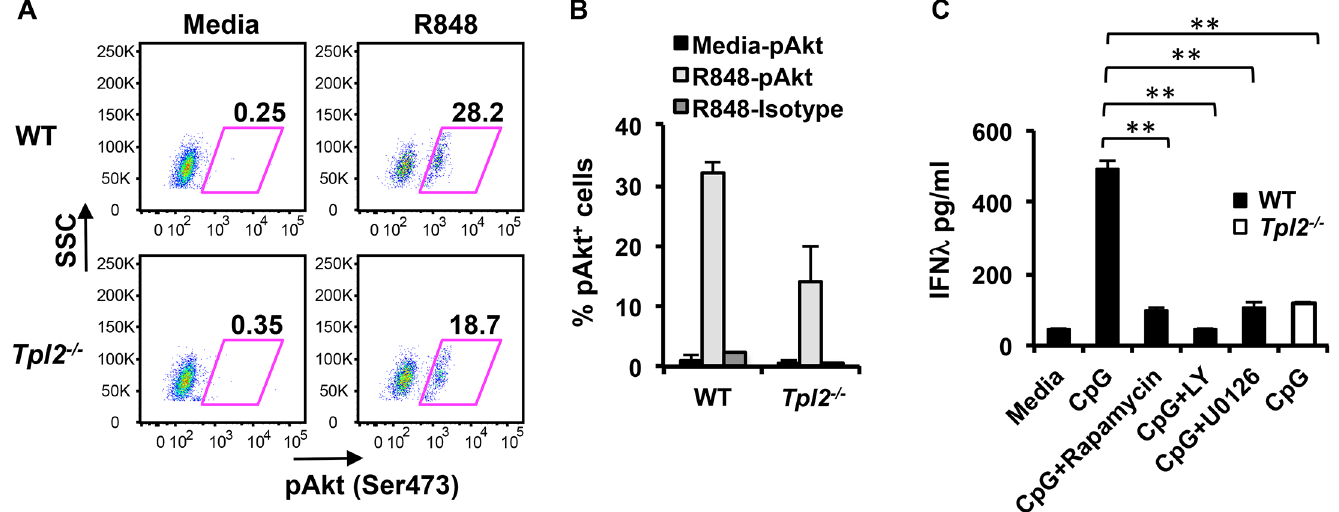
Fig 4. ERK and Akt are involved in Tpl2-dependent IFN λ production in pDCs. pDCs from WT and Tpl2 -/- mice were stimulated with R848 for 18 hr, and analyzed by intracellular staining for pAkt Ser473 . (A) Representative flow cytometry plots showing pAkt Ser473 staining within pDCs. (B) Proportion of pAkt positive pDCs from 2 independent experiments. (C) pDCs were pretreated with inhibitors for 30 min before stimulation with CpG, and IFN λ levels were measured by ELISA. Data are representative of 2 (A-B) or 3 (C) independent experiments. Graphs show means ± SD. * indicates p < 0.05, ** indicates p <